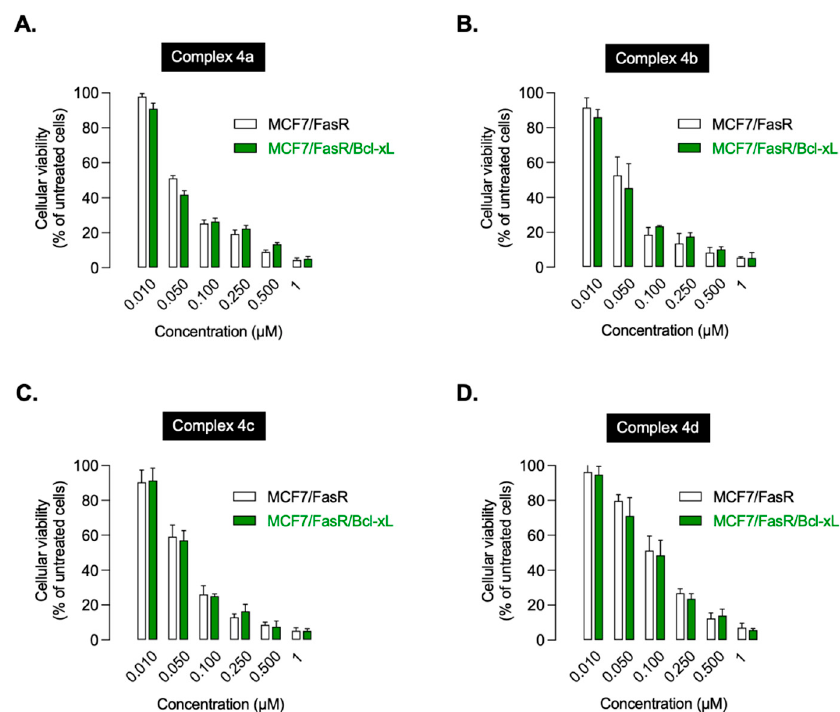
Figure 12. Bcl-xL does not inhibit cell death induced by complexes 4a – d . MCF7/FasR